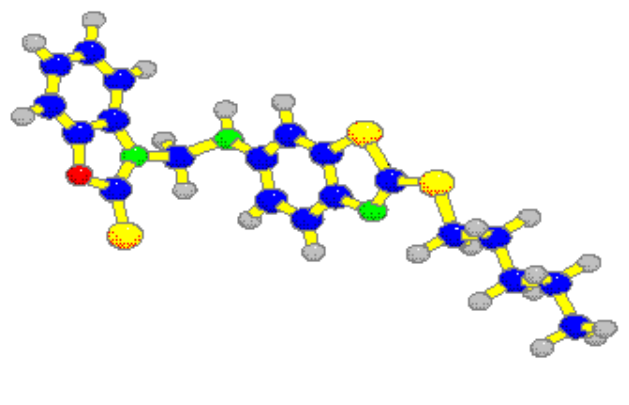
) CH ). Oxygen is indicated by red, 2 4 3